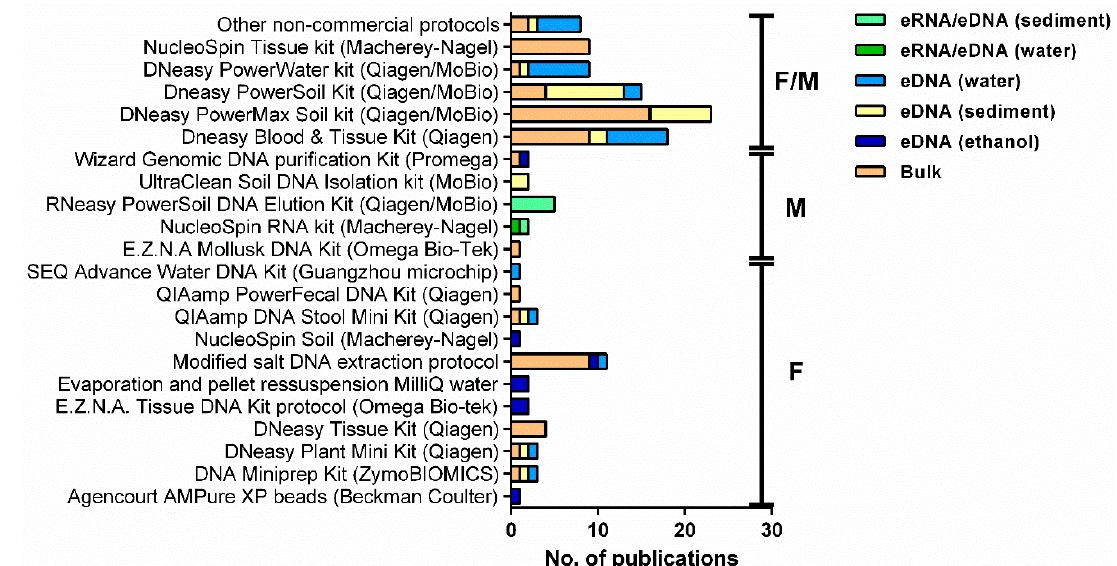
Figure 4. DNA extraction methodologies used for assessing macroinvertebrate diversity through metabarcoding in (F) fresh and (M) transitional/marine waters.